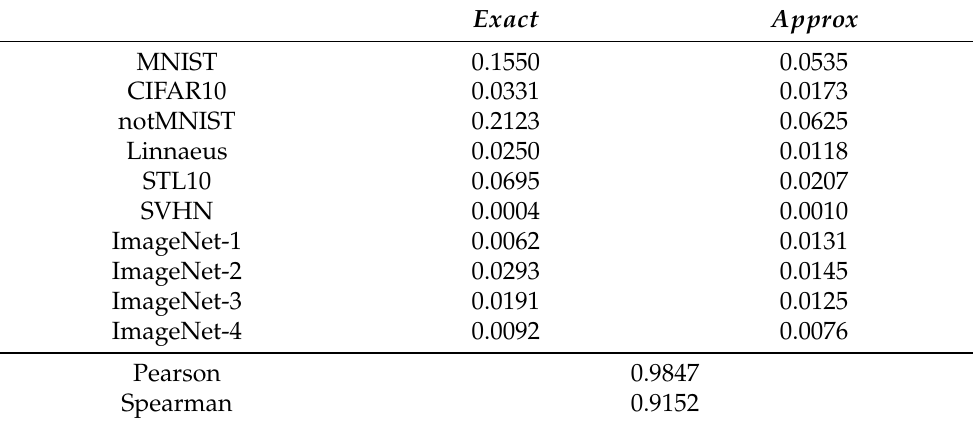
Table 6. Comparison of Exact and Approx values and their correlations. Pearson and Spearman are the Pearson and Spearman rank correlation between the Exact and